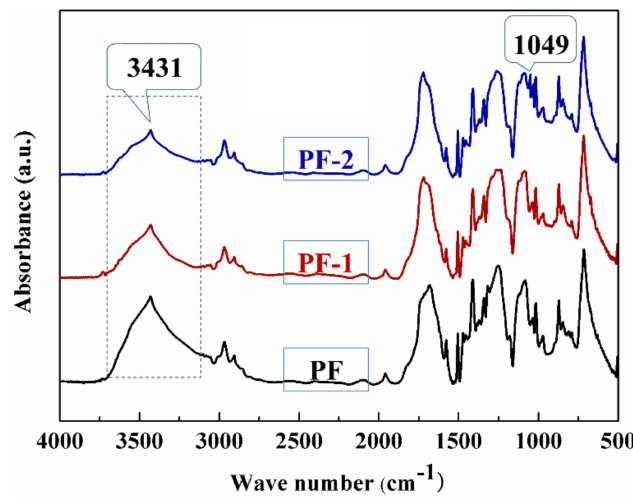
Figure 8. FT-IR spectra of PET filaments.